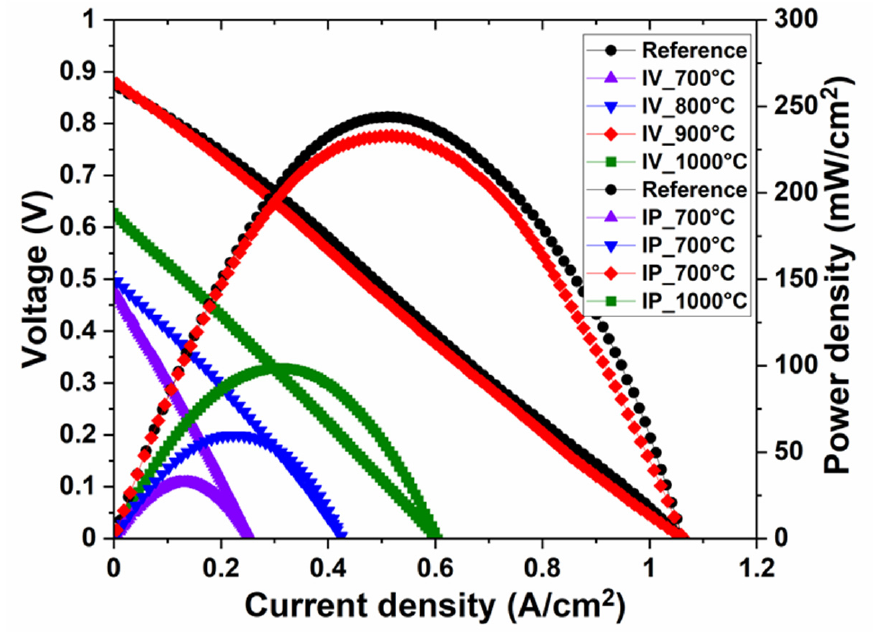
Figure 5. IV and IP curves of the printed single-layer cells sintered at 600 °C, 700 °C, 800 °C, 900 °C and 1000 °C, and the pressed single-layer cell (reference) sintered at 700 °C. All the cells were supplied with H 2 on one side and air on the other side, with Au and Ni foam serving as the current collector on both sides. These measurements were carried out at 550 °C. Table 1. The peak power density and the total cell resistance under fuel cell conditions, and the BET surface area of the printed cells and the reference pressed